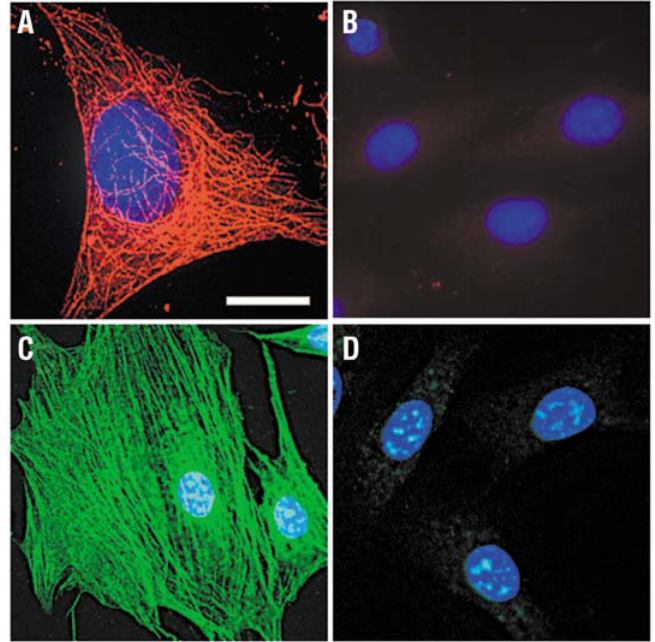
Figure 4. Staining of cytoskeleton fibers in 3T3 mouse fibroblast cells with QD-streptavidin. ( A ) Microtubules were labeled with monoclonal anti- α -tubulin antibody, biotinylated anti-mouse IgG and QD 630-streptavidin (red); ( B ) Control for ( A ) without primary antibody; ( C ) Actin filaments were stained with biotinylated phalloidin and QD 535-streptavidin (green); ( D ) Control for ( C ) without biotin-phalloidin. The nuclei were counterstained with Hoechst 33342 blue dye. Filter sets ex. 480 ± 20 nm/em. 535 ± 10 nm and ex. 560 ± 27.5 nm/em. 635 ± 10 nm were used to observe signals of QD 535 and QD 630, respectively. Scale bar, 10 μ m for ( A ), 24 μ m for ( B ) through ( D ). Reprinted with permission from [25]. Copyright 2003 Nature Publishing